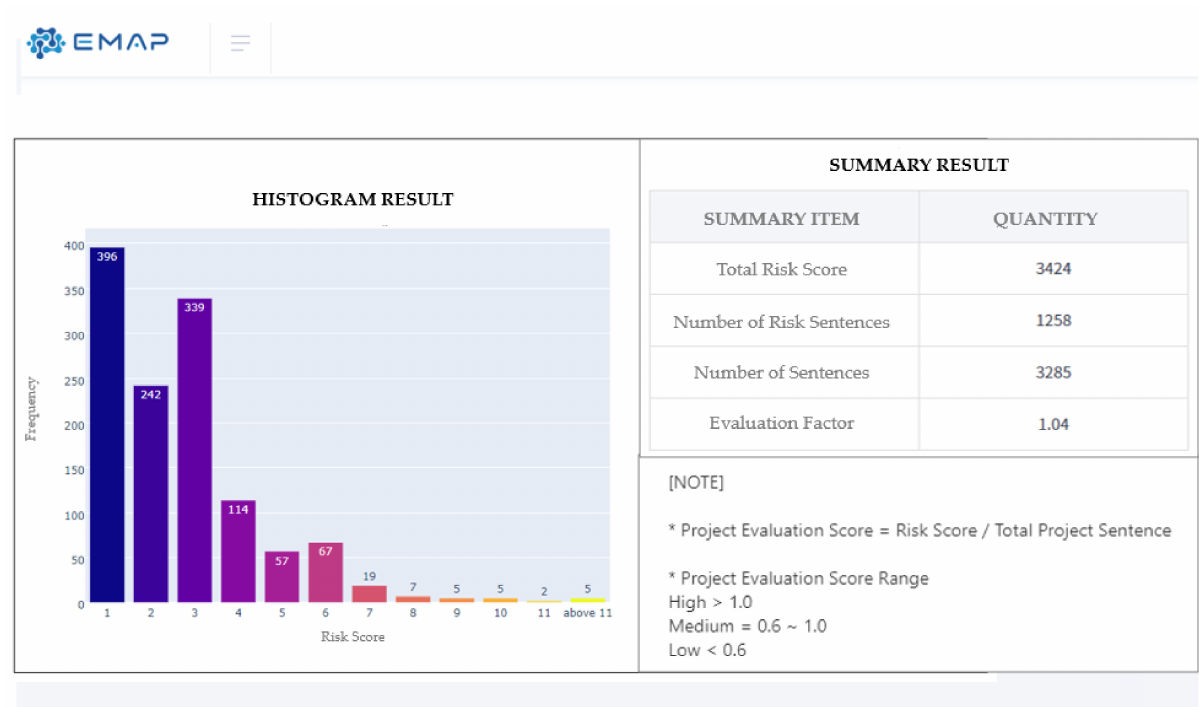
Figure 11. TRE result summary